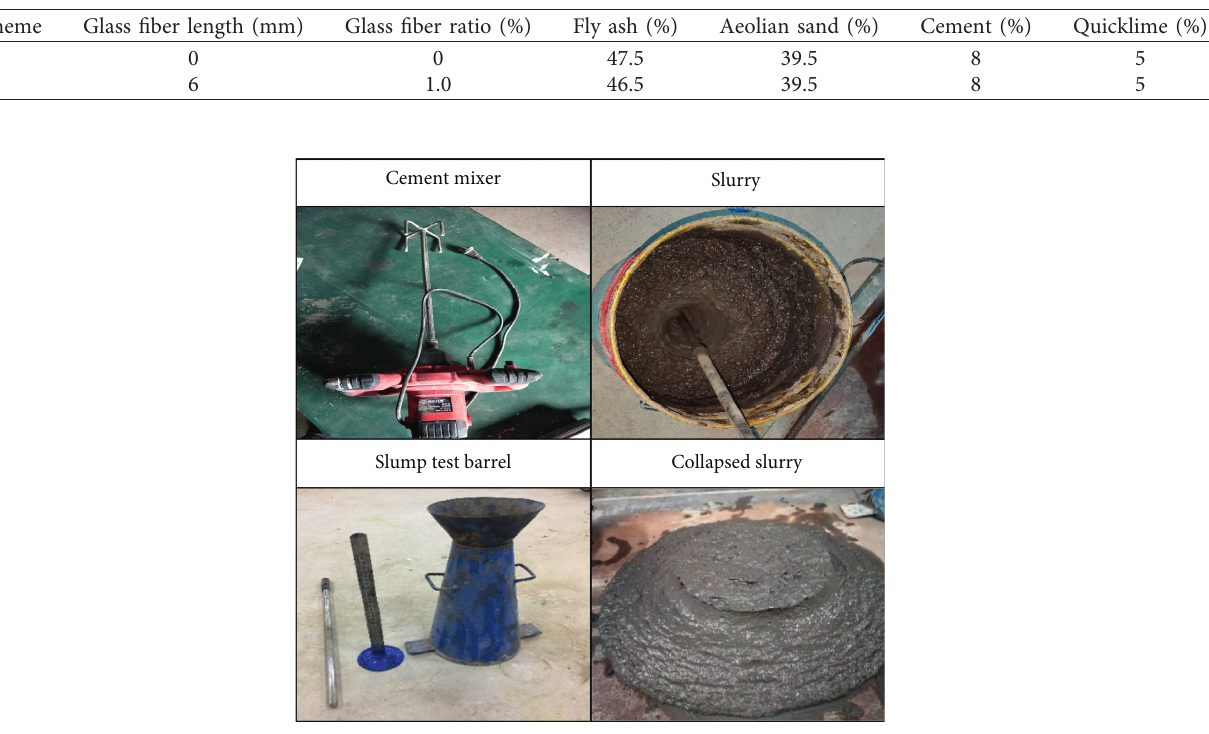
Table 3: Doping ratios of glass fibers and the CPB materials.